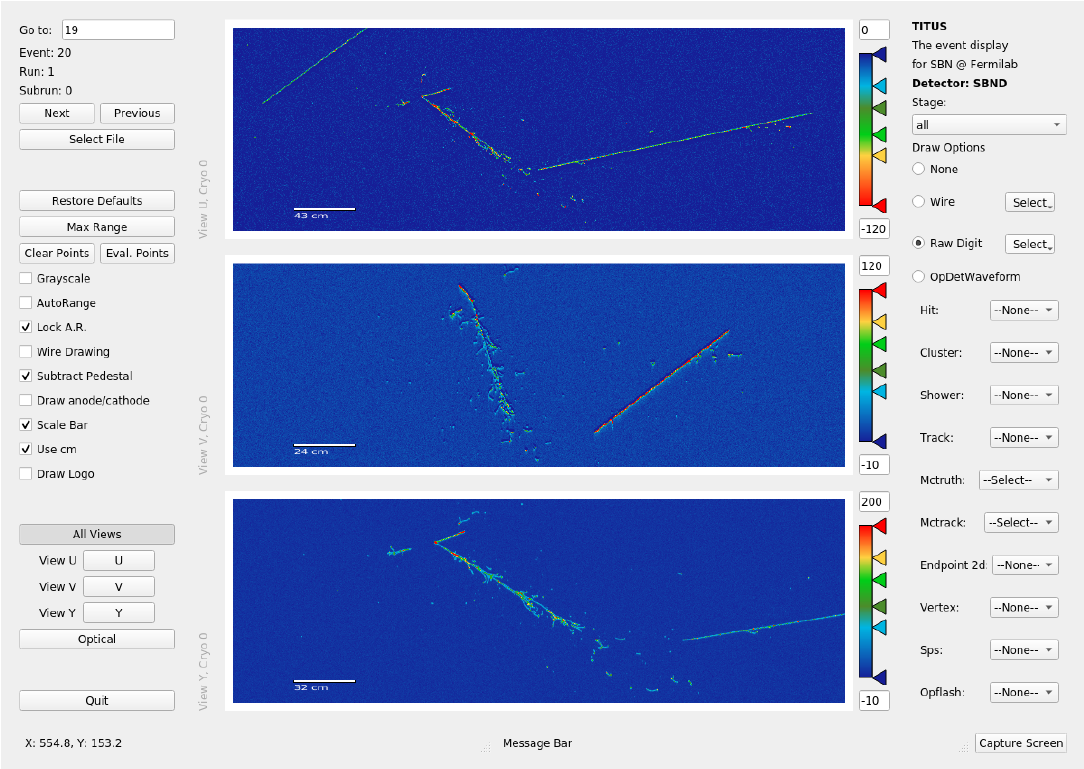
Figure 3. The main view of the TITUS event display. Here showing a simulated neutrino event in the SBND detector [1].